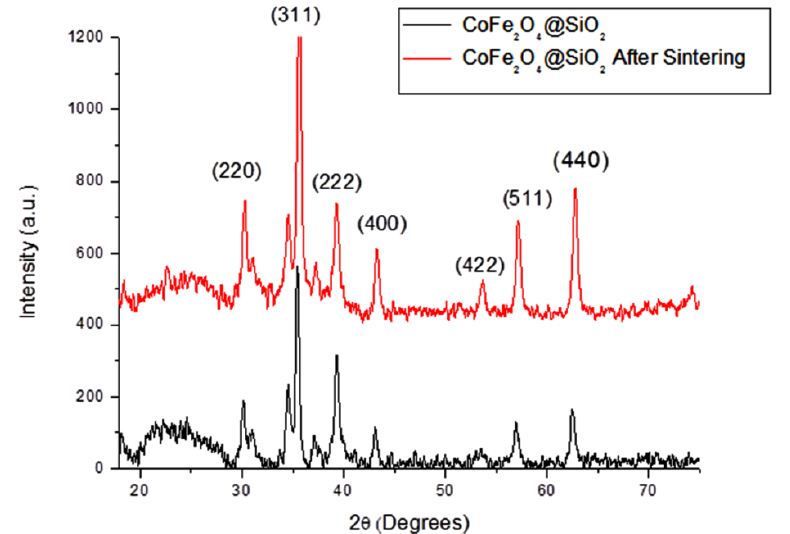
Figure 4. XRD pattern of SiO 2 coated CoFe 2 O 4 nanoparticles before and after sintering at 600